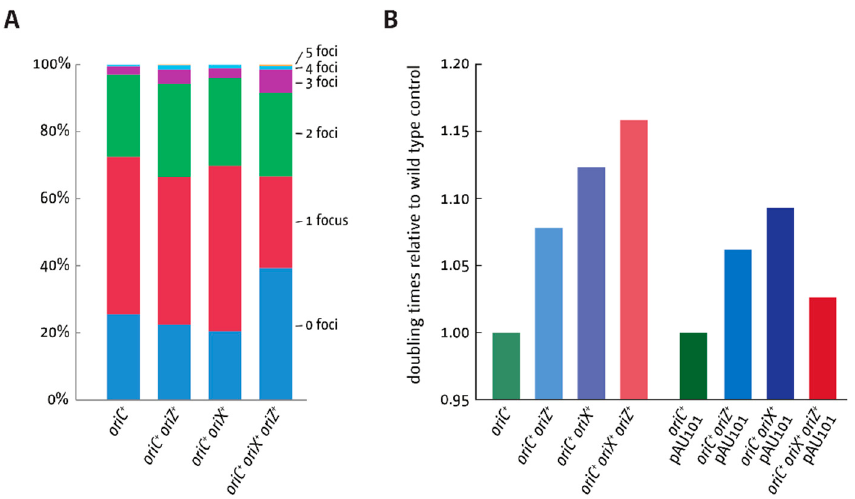
Figure 7. Replisome numbers and doubling times of cells with one and two ectopic replication origins. ( A ) Replisome numbers (YPet-DnaN) in wild-type, oriC + oriX + , oriC + oriZ + , and oriC + oriX + oriZ + cells. A minimum of 300 cells from at least three independent experiments were analysed per strain. Shown are the average focus counts per strain and focus class. The strains used were AS1062 ( ypet-dnaN ), RCe749 ( oriC + oriZ + ypet-dnaN ), RCe751 ( oriC + oriX + ypet-dnaN ), and RCe753 ( oriC + oriX + oriZ + ypet-dnaN ). ( B ) Doubling times of E. coli cells with one or two ectopic replication origins in the presence and absence of an additional copy of the dnaA gene expressed from a low copy number plasmid from its native promoter. All doubling times were determined by measuring viable titres of cultures grown in LB broth (see Material and Methods for details). Changes in doubling times relative to wild-type cells are shown due to the fact that the presence of ampicillin necessary for plasmid selection causes a mild change in doubling times (see Table S2). The strains used were MG1655, RCe504 ( oriC + oriZ + ), JD1181 ( oriC + oriX + ), and JD1333 ( oriC + oriX + oriZ + ) in the presence or absence of plasmid pAU101 (see Supplementary Methods), as indicated.